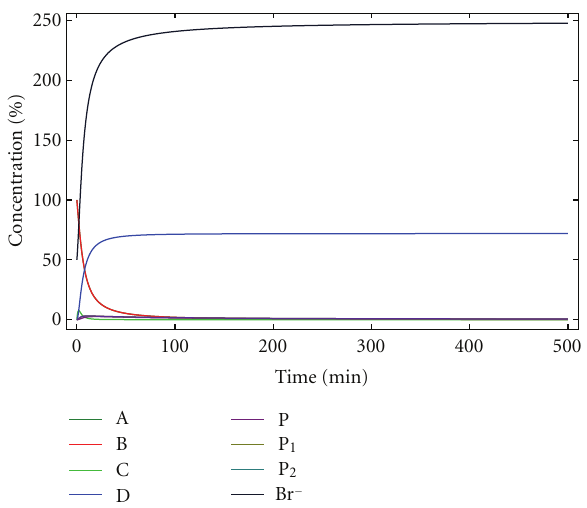
Figure 13: Concentration of the reactants, products, and reac- tion intermediates versus time for kinetic model 8. [A] 0 = [B] 0 = 0.005 M, [Br − ] 0 = 0.0025 M, k 1 = 10M − 1 min − 1 , k 1 c = 4000 M − 2 min − 1 , k 2 = 0.5min − 1 , and k 2 c = 200M − 1 min − 1